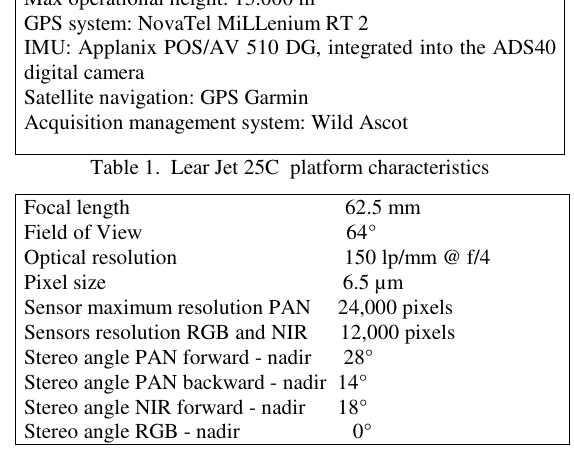
Table 2. Digital camera